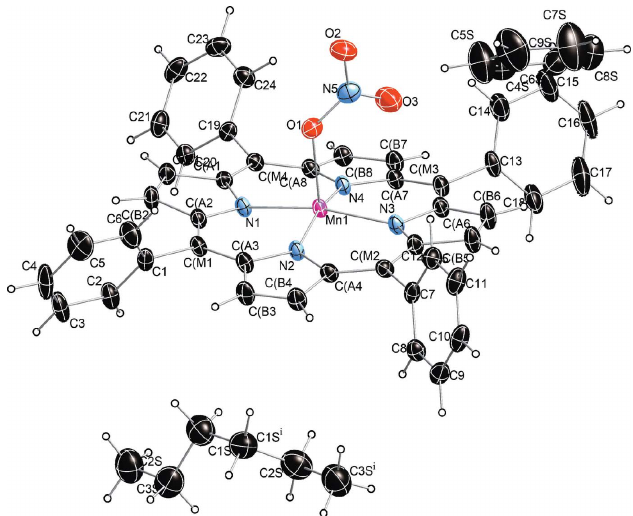
Figure 1 The molecular structure of the title compound, drawn with displacement ellipsoids at the 50% probability level. Only one of the two orientations of the disordered benzene solvate molecules is shown. [Symmetry code: (i) (cid:5) x + 1 , (cid:5) y + 1 , z 2 2